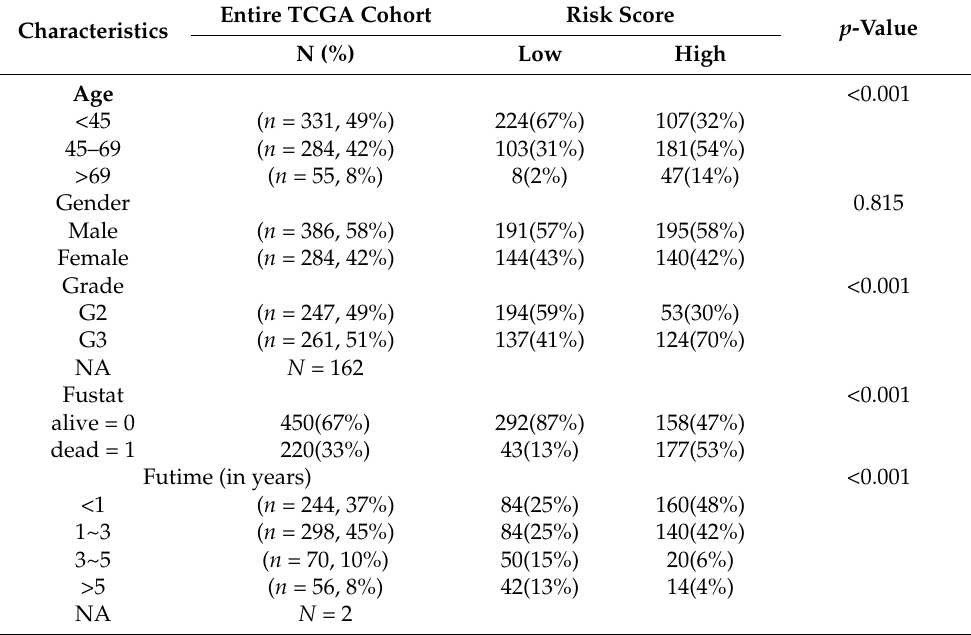
Table A2. The association of immune-related prognostic scores with patient clinical